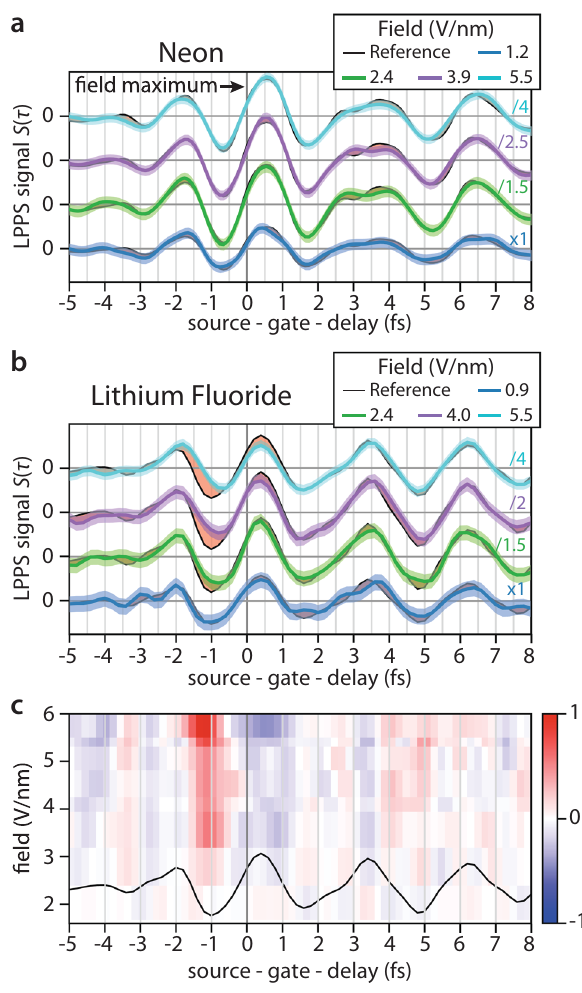
Fig. 3 Gate fi eld intensity-dependent linear petahertz photoconductive sampling (LPPS). LPPS measurements in a Ne and b LiF. We show LPPS signal S ( τ ) traces (colored) versus a reference (black) recorded at 1.7 V/nm peak gate intensity. Color-shaded areas (except red) denote standard deviations including the reference noise. At low gate fi eld amplitudes ( ≤ 2.4 V/nm), the LPPS signal deviation Δ S ( τ ) is within the measurement error bar, whereas signi fi cant deviations (marked red-shaded) appear before the gate pulse maximum at peak intensities higher than 2.4 V/nm. These measurements were taken on different days compared to the measurement in Fig. 2, therefore the detected gate fi eld vector potentials are different. c Time- and fi eld-resolved LPPS signal deviations Δ S ( τ ), black line: reference gate fi eld temporal evolution. For clarity, signals are constrained to the gate fi eld frequency spectrum below 1.2